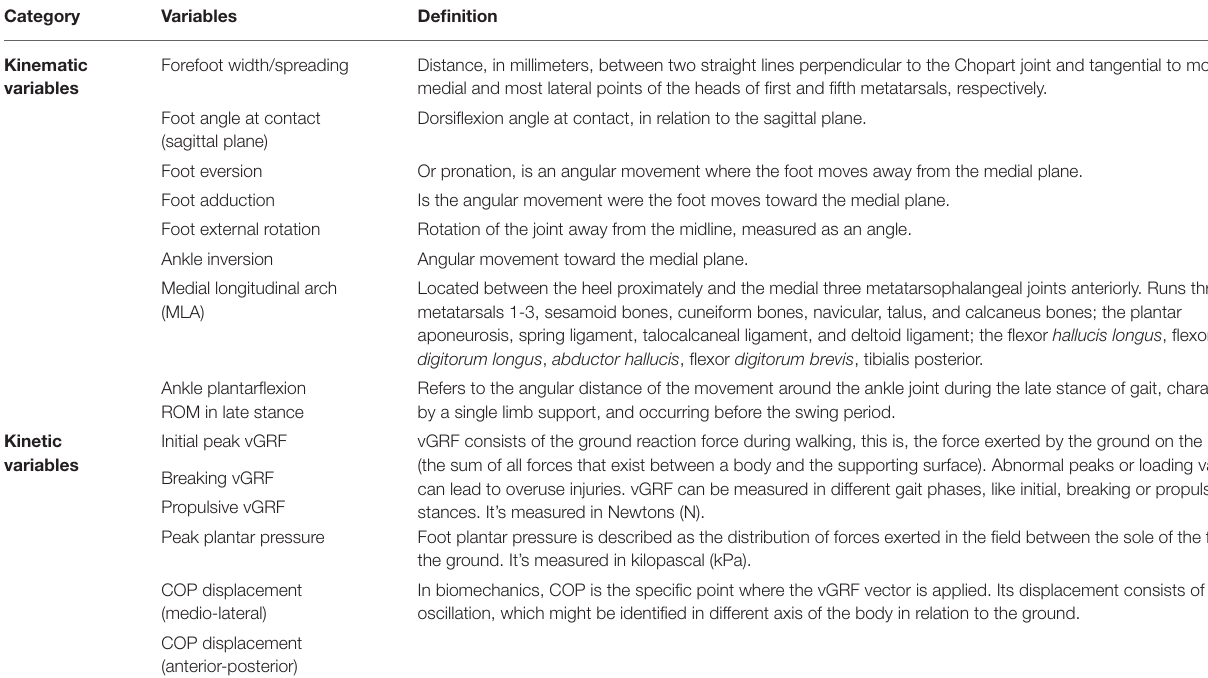
TABLE 1 | Specific podiatric profile variables. Category Variables Definition Kinematic variables